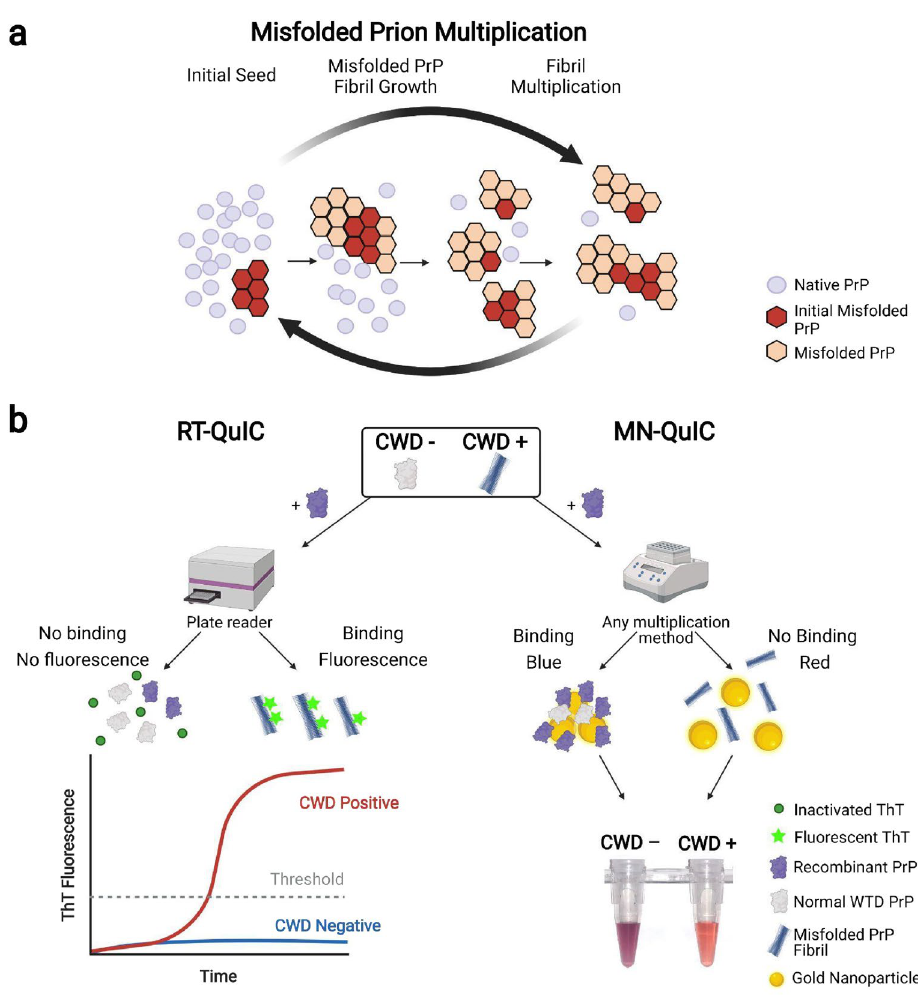
Figure 1. Overview of prion fibril multiplication and two prion amplification assays. ( a ) Schematic of misfolded prion fibril growth. The initial misfolded PrP (PrP CWD ) causes native PrP to misfold. ( b ) Overview of RT-QuIC and MN-QuIC. RT-QuIC: Seeds originating from tissue samples of cervids (whether CWD negative or CWD positive) are added to recombinant PrP solutions. These solutions are then shaken and incubated for ~ 48 h (depending on sample type). If present, misfolded PrP fibrils (PrP CWD ) from CWD positive tissue induce conformational changes of the recombinant PrP. Amplification results are read in real-time with ThT fluorescence. MN-QuIC: After 24 h amplification, products are diluted and added to an AuNP solution. CWD positive samples result in a red solution (peak absorbance wavelength ~ 516 nm) while CWD negative solutions are blue/purple (peak absorbance wavelength ~ 560